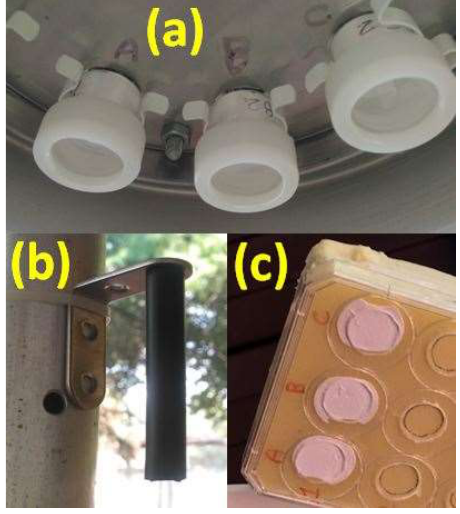
Figure 4. Outdoor exposure conditions, holders for: axial diffusive dosimeters ( a ), radial diffusive dosimeters ( b ), direct exposure ( c ).